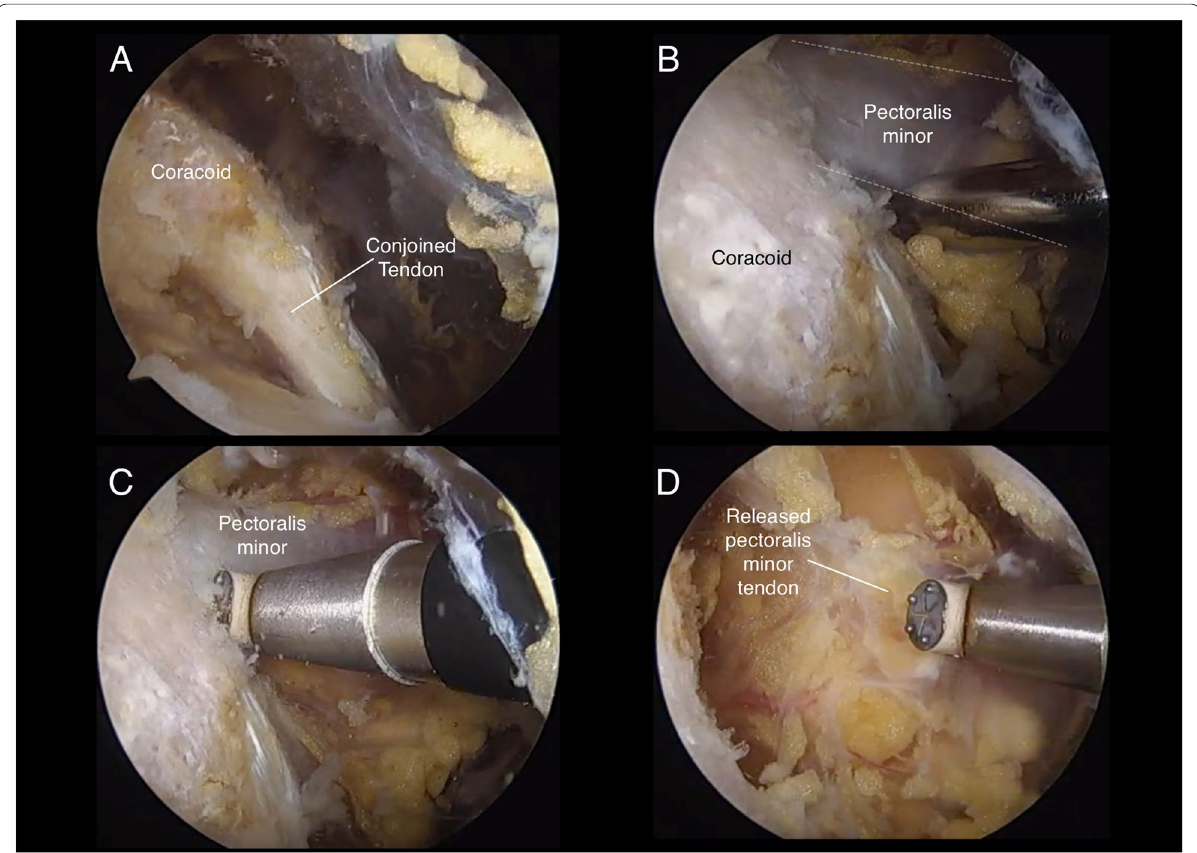
Fig. 2 Endoscopic release of the pectoralis minor. A Identification of the coracoid tip and conjoined tendon from the subdeltoid space. B Identification and dissection of the pectoralis minor tendon. C Release is performed from distal to proximal with the radiofrequency ablation device oriented directly towards the coracoid process. D Complete release of the pectoralis minor tendon is confirmed by visualizing medial retraction of the muscle‑tendon